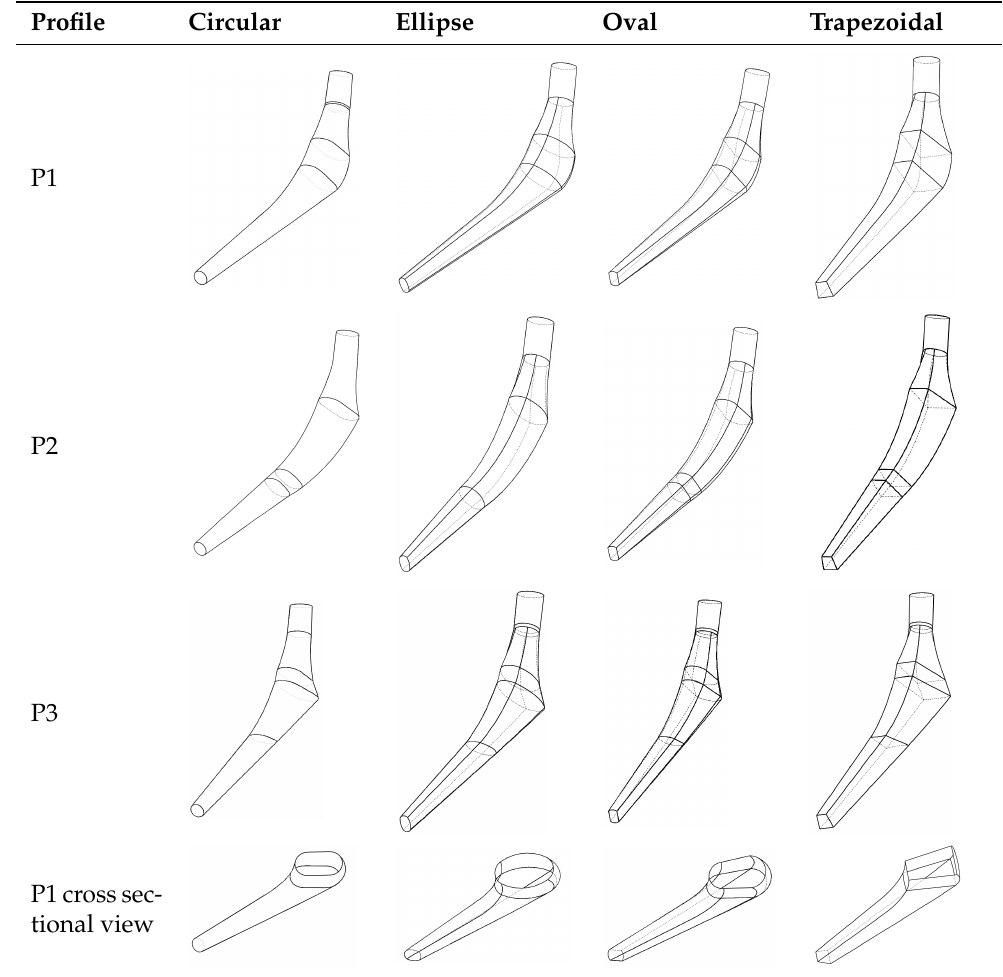
Table 4. Different prosthesis designs and cross-sectional areas based in the information presented by Sabatini et al. [9] and Oshkour et al. [2]. P1 means Profile 1, P2 means Profile 2, and so on, and their corresponding cross-sectional areas are indicated (circular, ellipse, oval, and trapezoidal). In the last row, the different views of the cross-section areas in the proximal part of the stem from Profile 1 can be